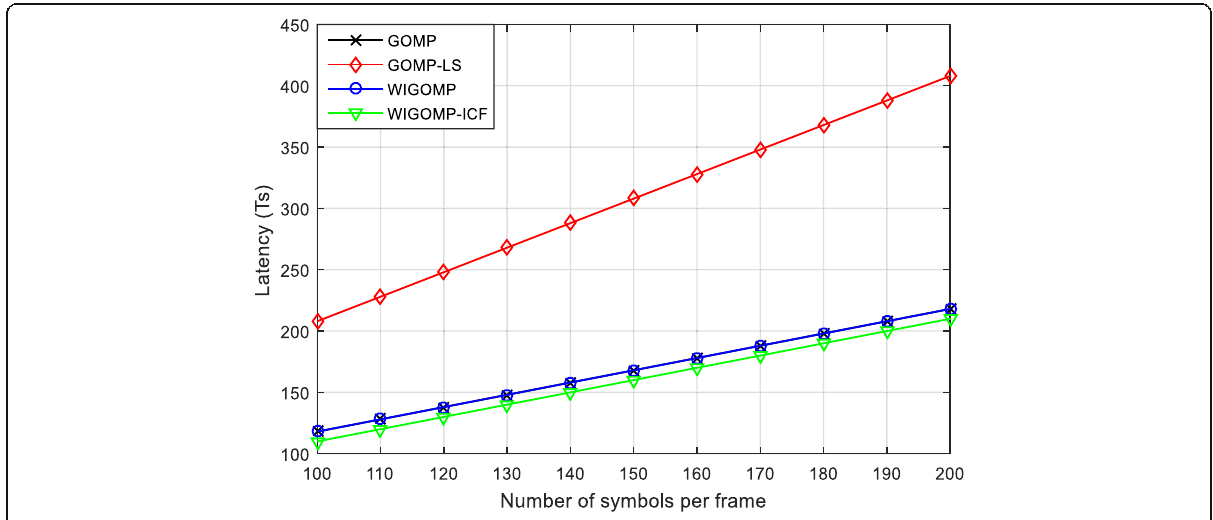
Fig. 7 Number of symbols per frame versus latency